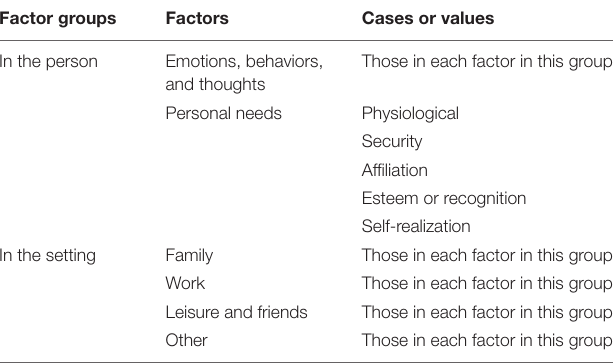
TABLE 1 | Parameters of the elements of attributions. TABLE 2 | Attribution framework